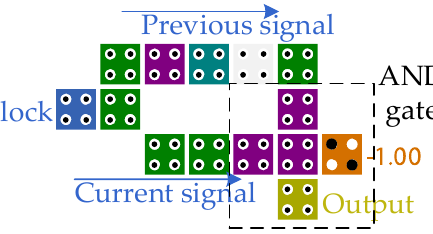
Figure 10. Negative edge detection circuit [16]. Table 4. Negative edge trigger truth table.